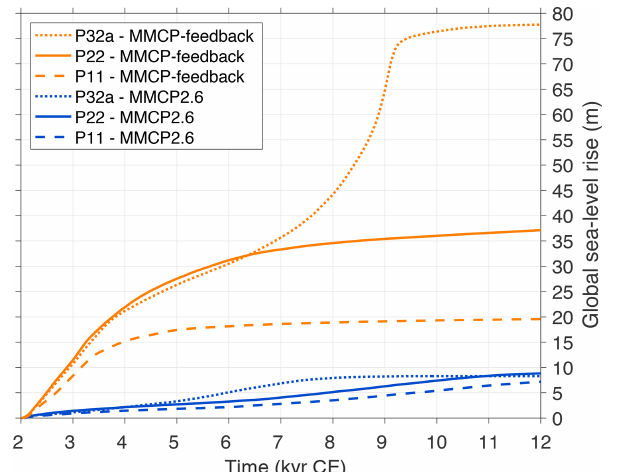
Figure 13. Global sea-level rise for three different climatic pa- rameter sets of LOVECLIM using forcing scenario MMCP2.6 and MMCP-feedback. GMSL change from our preferred parameter set P22 is given in solid lines.